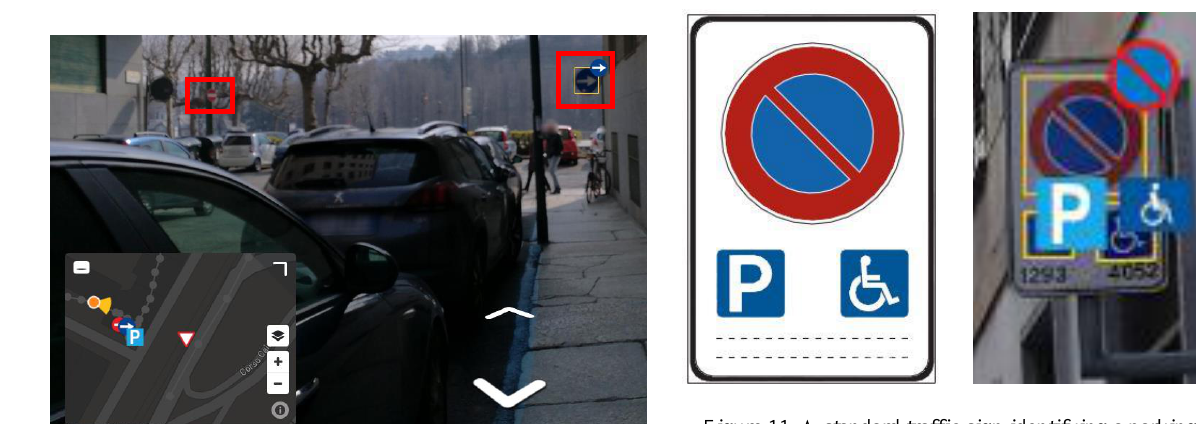
Figure 11. A standard traffic sign identifying a parking lot reserved to a disabled person (left) and how it is recognised by Mapillary algorithm (right) Figure 9. Mapillary frame captured on road element having ID 4302692